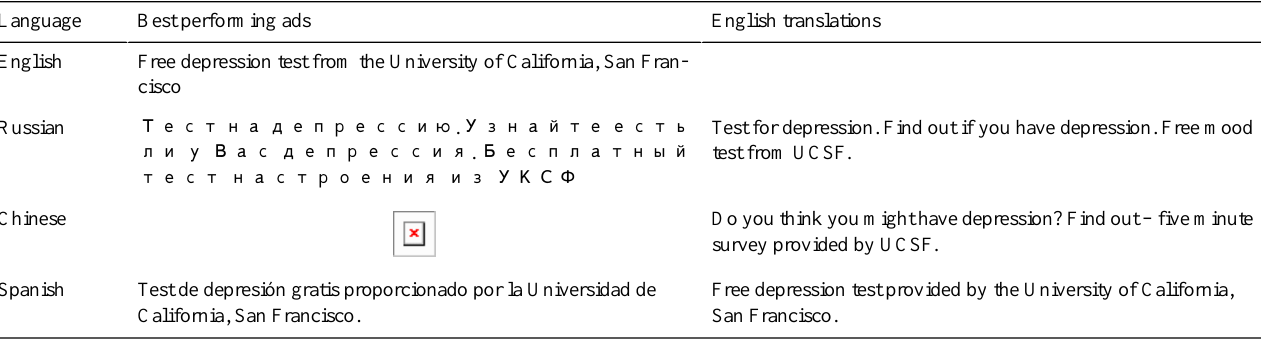
Table 5. Worst performing ads. Can’t eat, sleep, focus? Find out if you are depressed with a free UCSF.English online test from